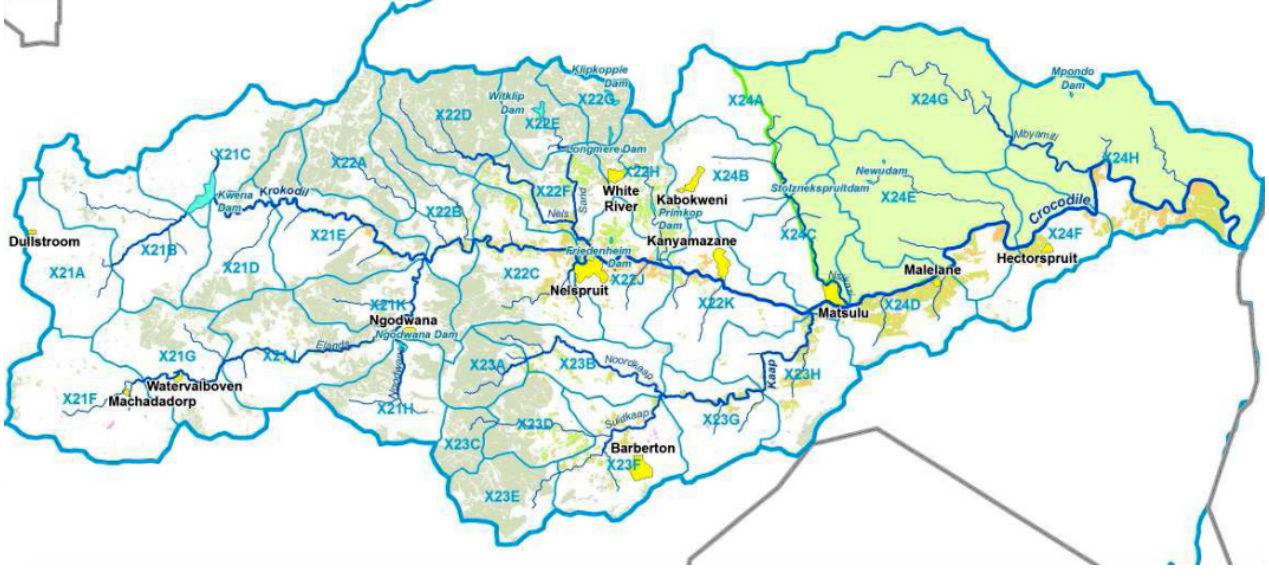
Fig. 1 . Map of the Crocodile River within the Inkomati Water Management Area, South